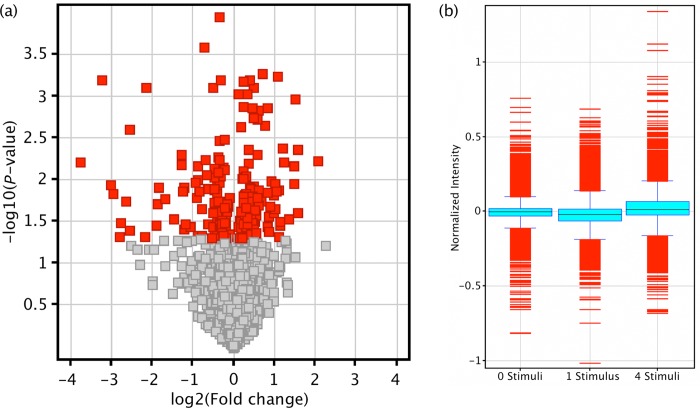
miRNA and mRNA responses to depolarization in whole cells. miRNA and mRNA microarrays were performed on 3 biological replicates of resting cells and cells subjected to one single or four sequential K+ depolarizations. (a) Volcano plot comparing miRNA expression between resting and single-depolarized cells demonstrates the bias for down regulation of miRNA in response to activity. Each square represents a single miRNA plotted by fold change (x-axis) and significance (y-axis). (b) Boxplot of mRNA microarray data. Compared with resting cells (left), the mRNA profile of cells was reduced by a single stimulus (centre). After 4 successive depolarizations (∼1 h), mRNA levels had recovered, and in fact exceeded that of resting cells (right).